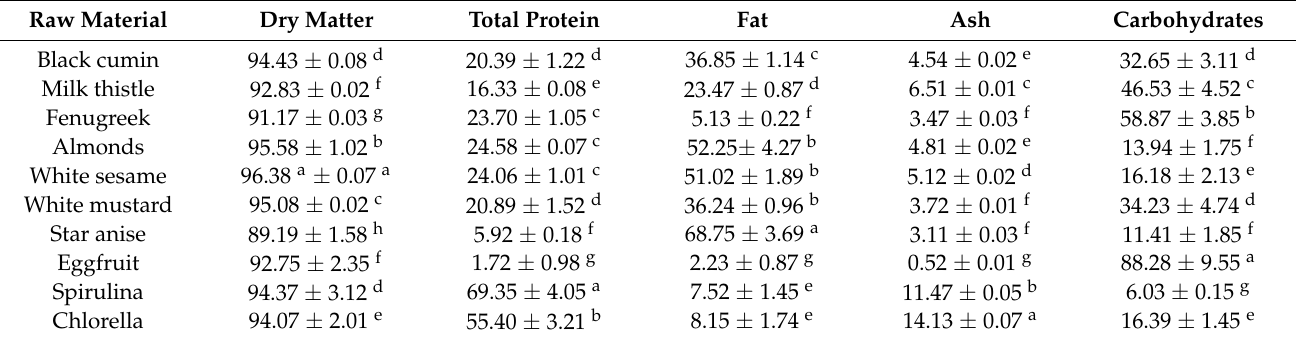
Table 2. Chemical compositions (g/100 g) of the analyzed plant